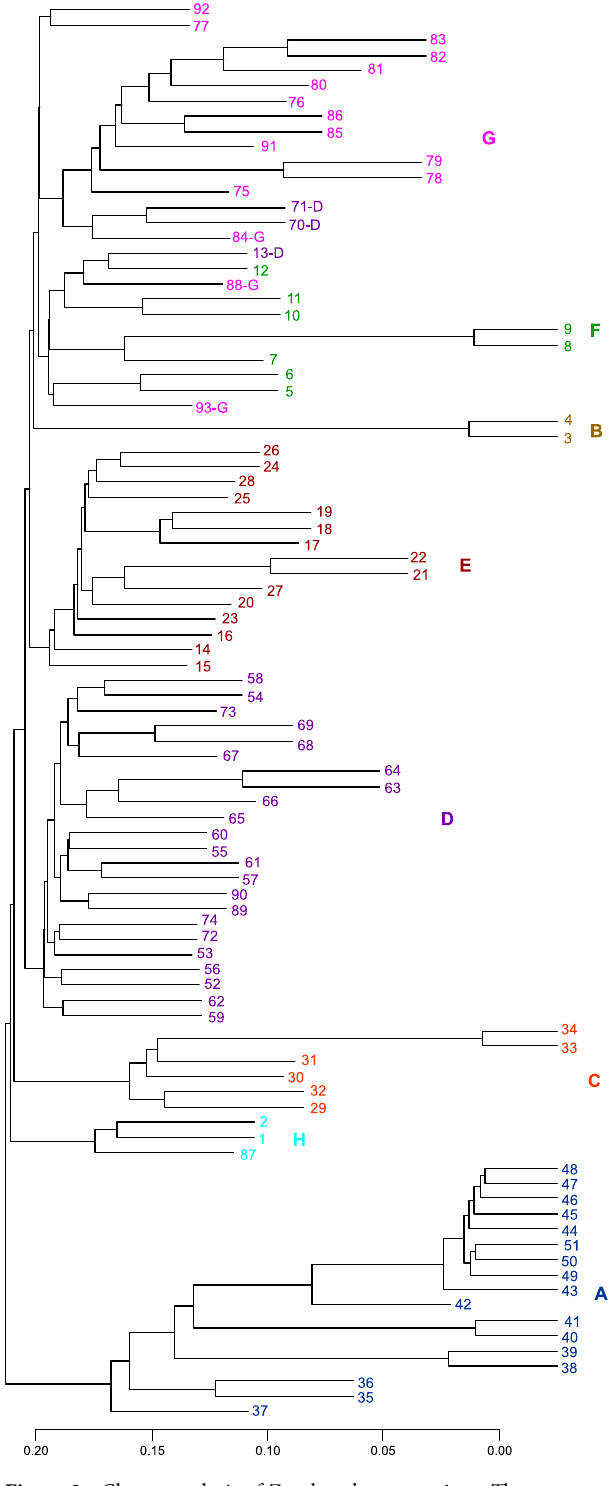
Figure 3. Cluster analysis of Zanthoxylum accessions. The new group, H group, is shown in light blue. The colour scheme is the same as in Fig. 1, with an additional colour. Figure was generated using R software (version 3.6.2) 44